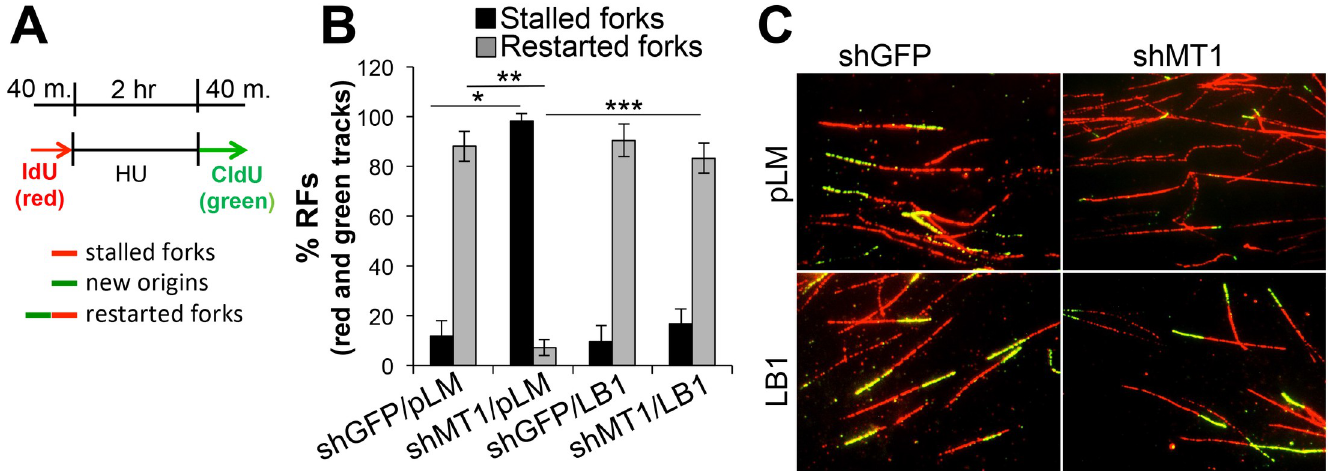
Fig 3. LaminB1 rescues stalling of replication forks caused by MT1-MMP inhibition. A) Schematic of experiment. Cells are pulsed with the nucleotide analogue IdU (red), followed by depletion of the nucleotide pool with hydroxyurea, and chase with a second nucleotide analogue (green). Red only tracks: Stalled forks; red and green tracks: Restarted forks; green only tracks: New origins. B) % of replication forks (% RFs) was calculated by counting at least 200 red and green tracks for each condition. � , �� , ��� p < 0.0001, Student’s t test. C) Representative CldU (green) and IdU (red) stained DNA fibers.